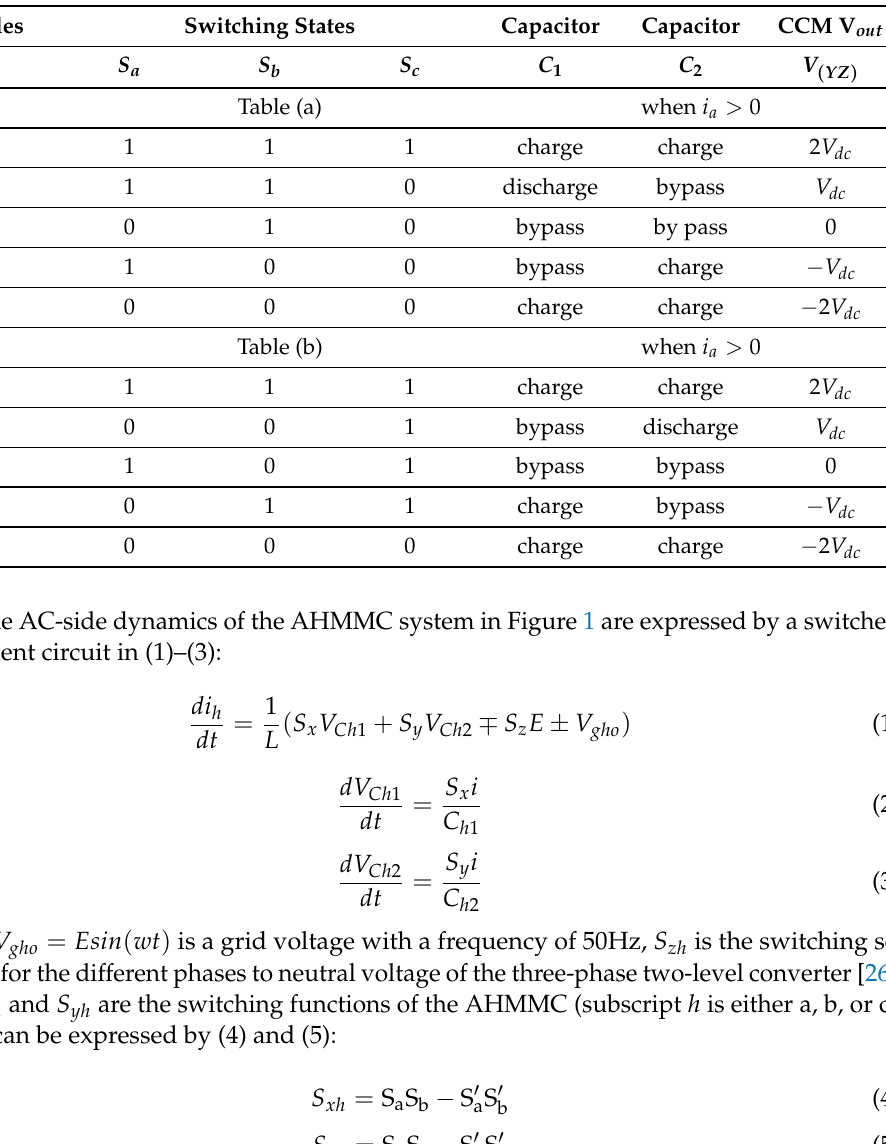
Figure 1. AHMMC topology. Table 1. Switching modes of